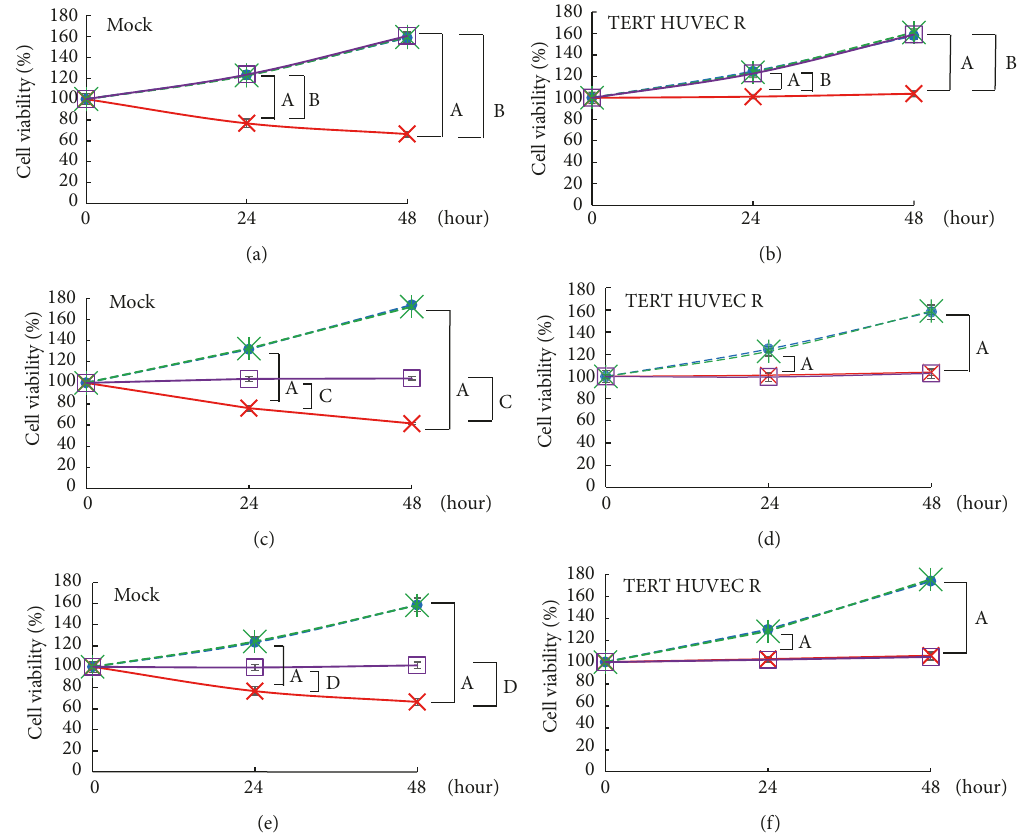
Figure 3: Effect of ROS inhibitors on TNF- 𝛼 stimulation. Cells were treated with 20ng/mL TNF- 𝛼 for either 24h or 48 h. Cell viability at 0 h was taken as 100%. (a) and (b) representthe cell viability of the mock cells and TERT HUVEC R cells pretreated with 5 mM NAC, respectively. Blue circle: untreated; red cross: TNF- 𝛼 ; green asterisk: NAC; purple square: TNF- 𝛼 + NAC. (c) and (d) represent the cell viability of mock cells and TERT HUVEC R cells pretreated with 20 𝜇 M DPI, respectively. Blue circle: untreated; red cross: TNF- 𝛼 ; green asterisk: DPI; purple square: TNF- 𝛼 + DPI. (e) and (f) represent the cell viability of mock cells and TERT HUVEC R cells pretreated with 30 𝜇 M apocynin, respectively. Blue circle: untreated; red cross: TNF- 𝛼 ; green asterisk: apocynin; purple square: TNF- 𝛼 + apocynin. n=3; A = P < 0.01, untreated versus TNF- 𝛼 ; B = P < 0.01, TNF- 𝛼 versus TNF- 𝛼 + NAC; C = P < 0.01, TNF- 𝛼 versus TNF- 𝛼 + DPI; D = P < 0.01, TNF- 𝛼 versus TNF- 𝛼 +